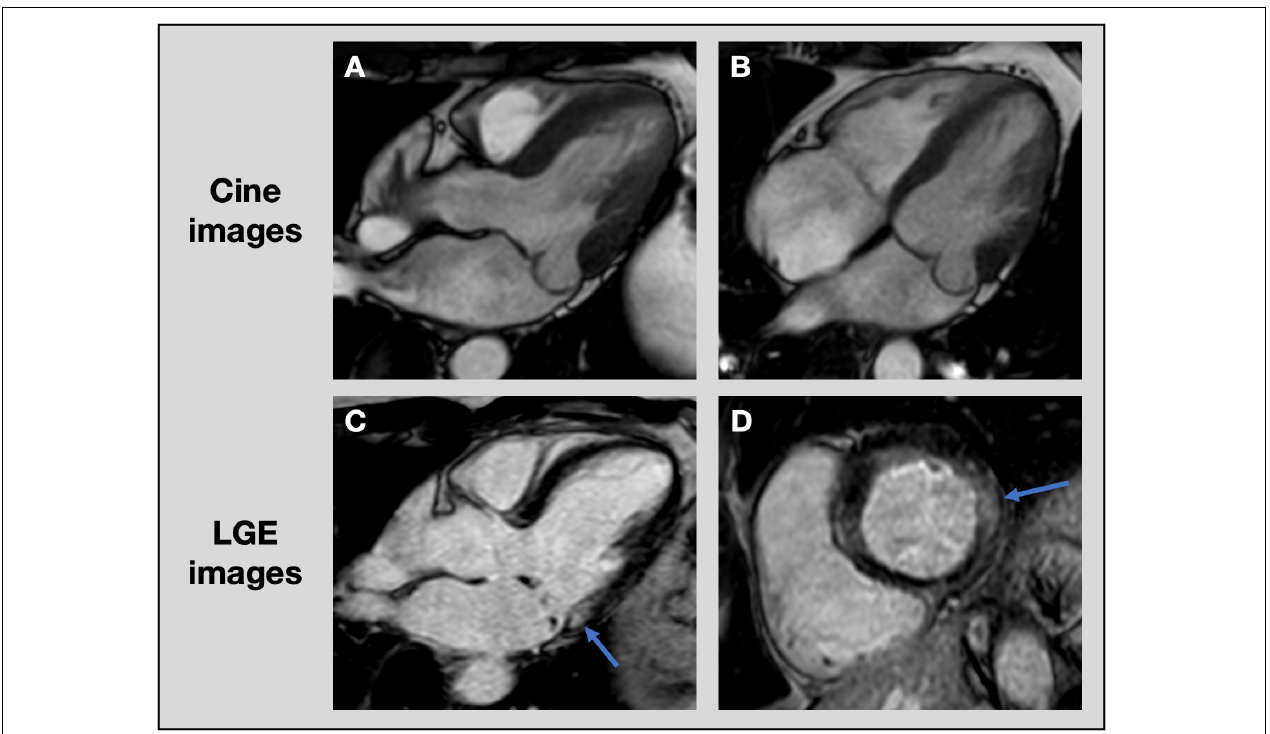
FIGURE 6 | Assessment of focal fibrosis with cardiac magnetic resonance imaging. CMR cine images of patient with posterior leaflet prolapse on 3-chamber (A) and 4-chamber (B) views. Late gadolinium enhancement images show evidence of focal fibrosis in the basal inferolateral wall (blue arrows) on 3-chamber (C) and short axis (D) views. CMR, cardiac magnetic resonance imaging; LGE, late gadolinium